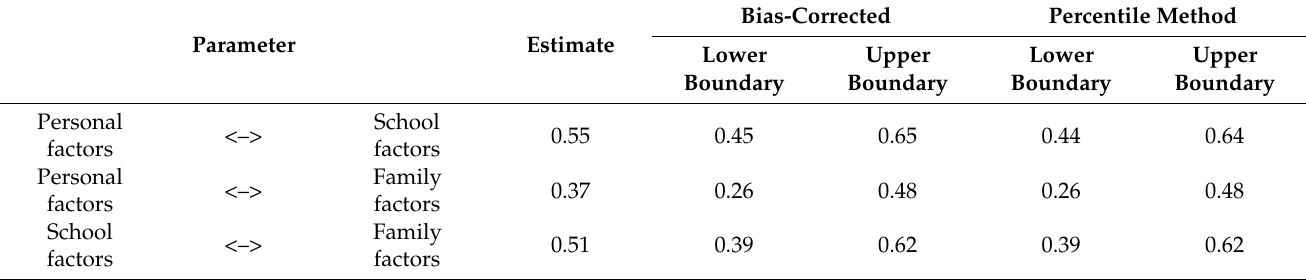
Table 6. Academic stress—hindrance—bootstrap 95% confidence interval table of related